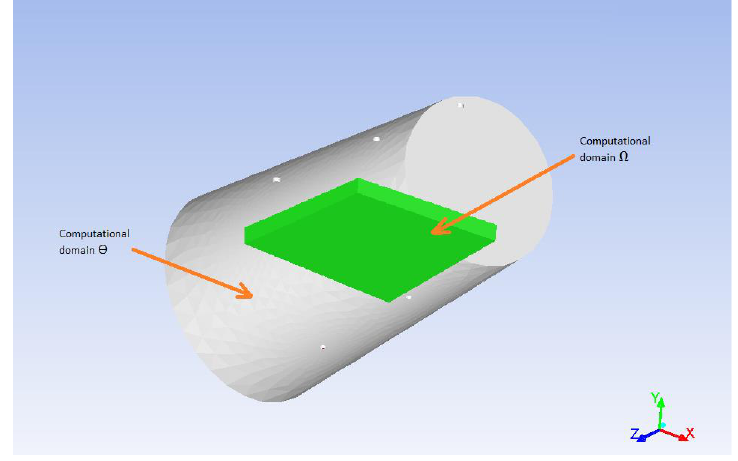
Figure 3. Model’s geometry .